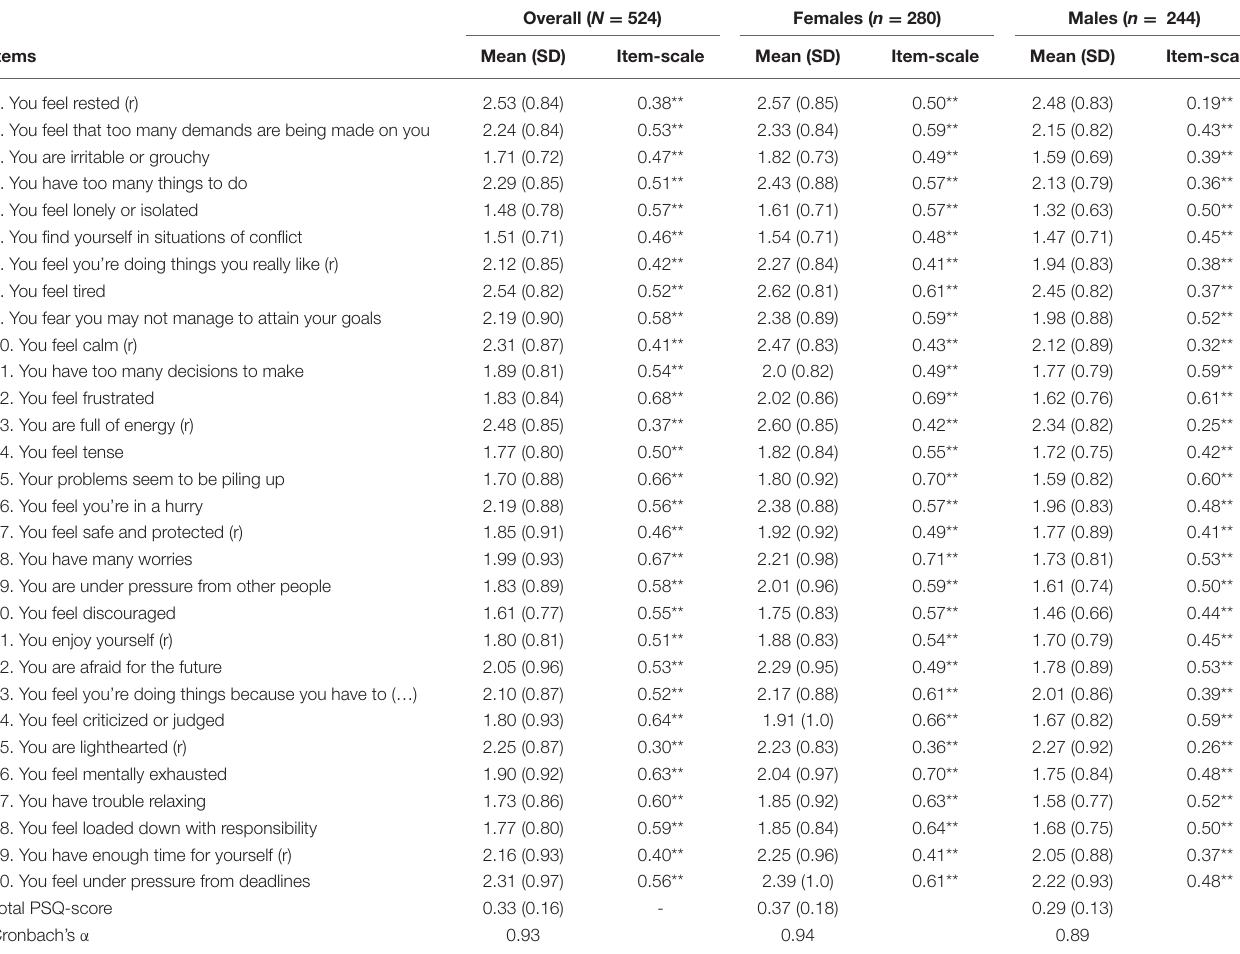
TABLE 1 | PSQ item mean (standard deviation) scores and corrected item-scale correlations, overall, and separately for gender.